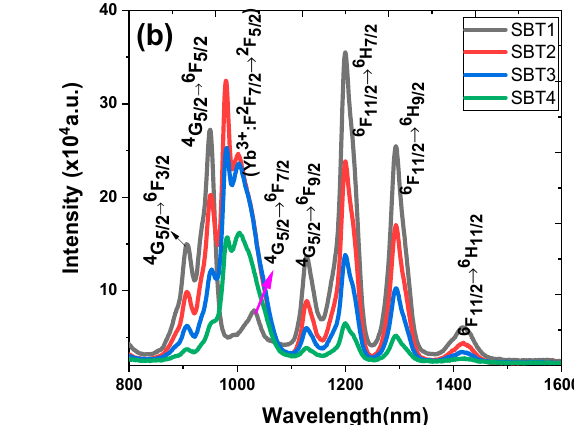
Figure 5. Partial energy-level diagram of Yb 3+ and Sm 3+ under 450 nm excitation source showing ground excitation state absorption, nonradiative processes (NR), cross-relaxation (CR), and resonant energy transfer (ET).